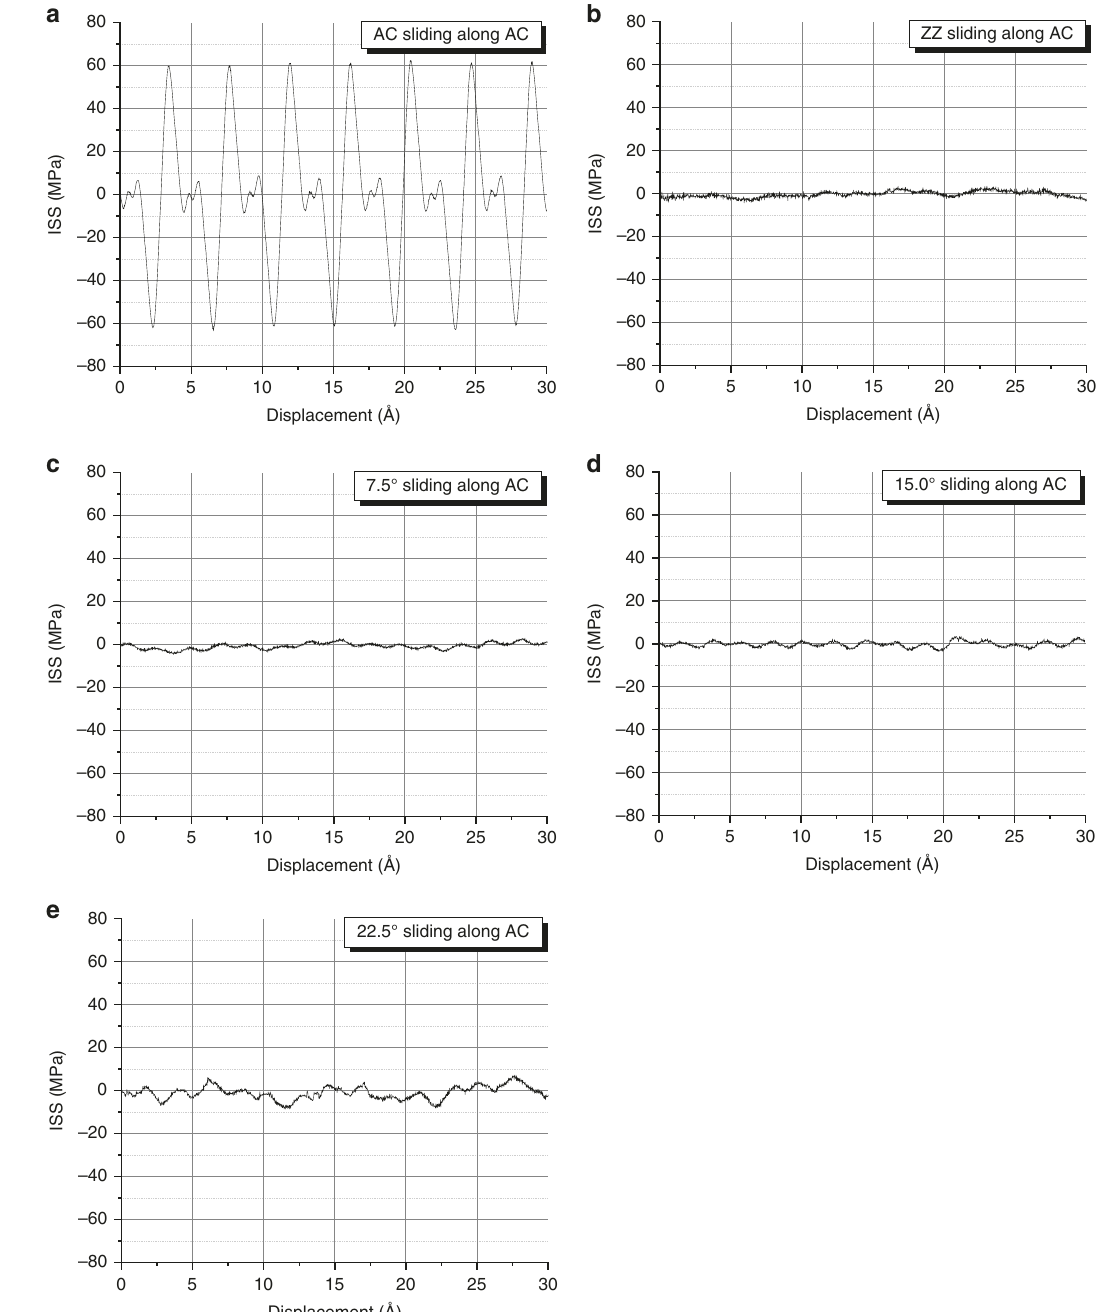
Fig. 6 Interlayer shear stress from MD simulations. ILSS values for various chiral directions at a temperature of 300 K, speci fi cally, a armchair, b zigzag, c 7.5°, d 15.0° and e 22.5°, sliding with respect to the armchair sublayer. It is observed that when shearing a monolayer graphene in achiral directions relative to the underline graphene, the stick-slip motion breaks down and the ILSS is signi fi cantly decreased. This is performed by employing the LCBOP